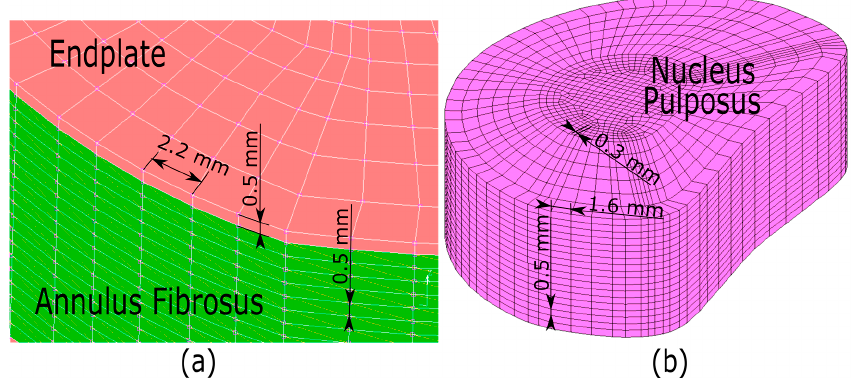
Figure 5. ( a ) Details of the mesh size for the endplate and annulus fibrosus; and ( b ) details of the mesh size for the nucleus pulposus.